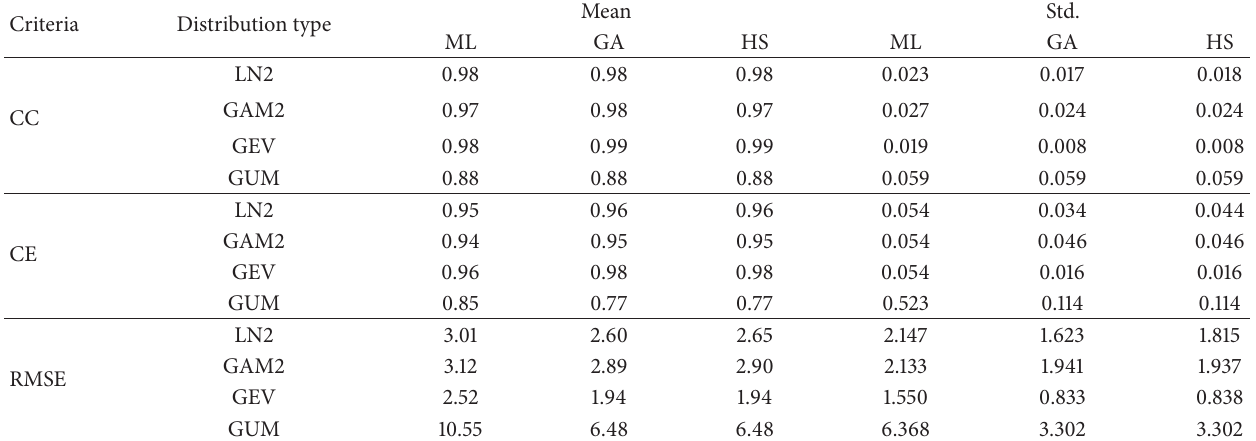
Table 5: The results of the parameter estimation for the four major cities in Republic of Korea. Rain gauge